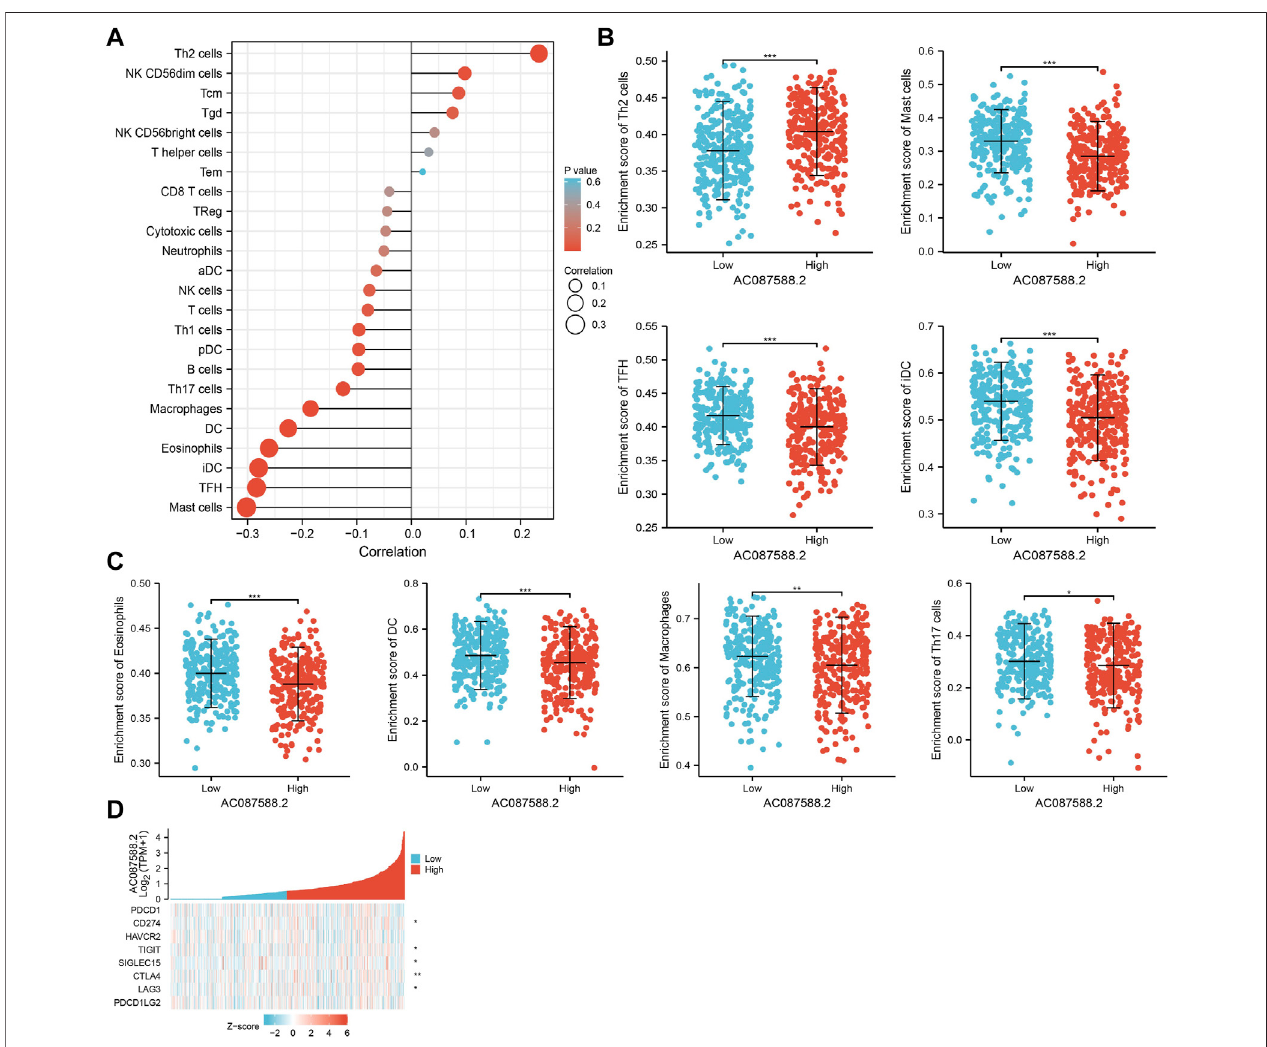
FIGURE 8 | Association between AC087588.2 expression and immune cell in fi ltration in LUAD. (A – C) Correlation between AC087588.2 expression and immune cell in fi ltration in LUAD. (D) Correlation between AC087588.2 expression and immune checkpoint-related genes in LUAD. * p < 0.05, ** p < 0.01, and *** p < 0.001.